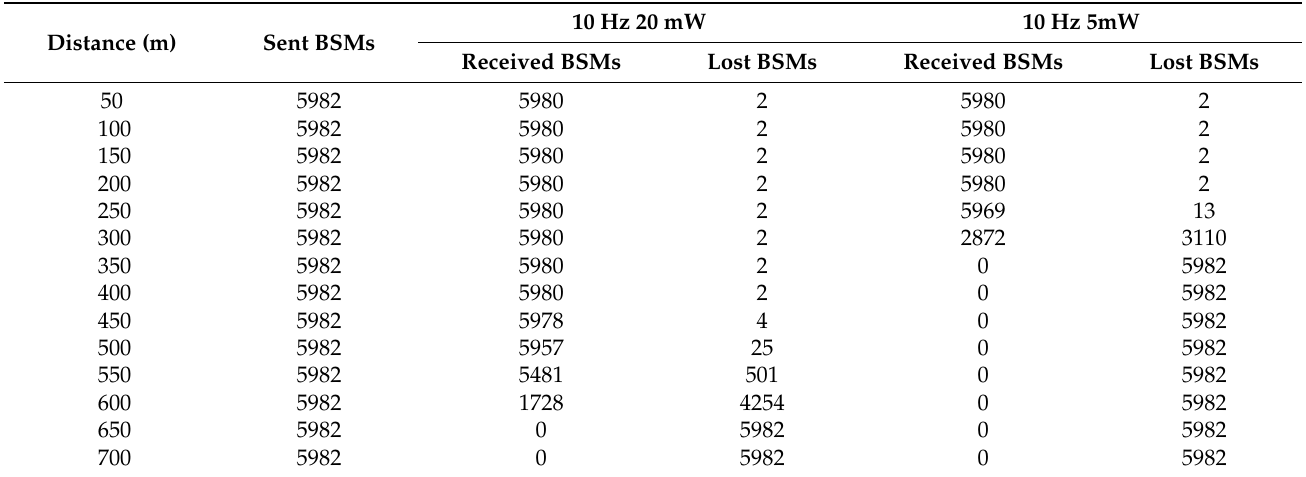
Table 1. Maximum transmission